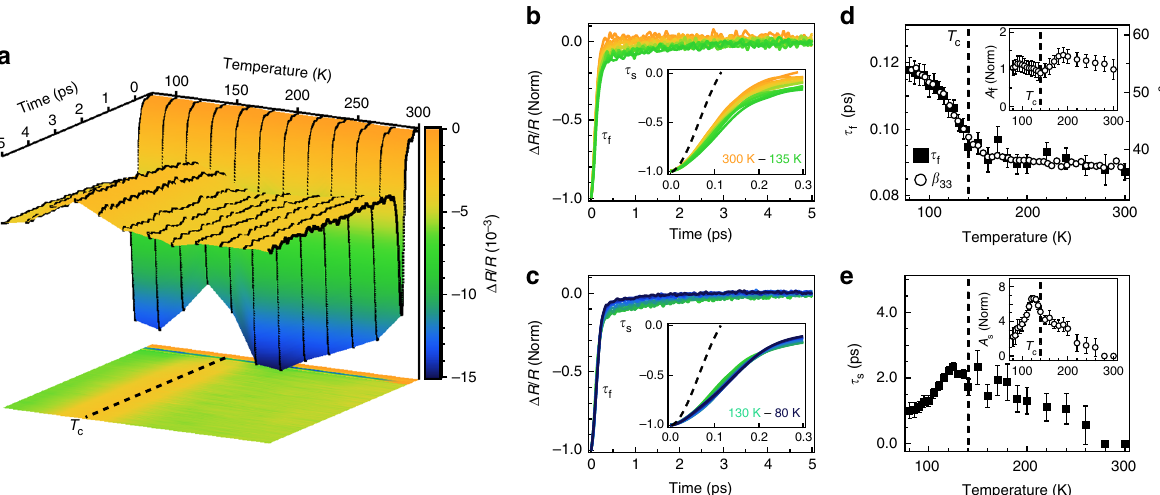
Fig. 2 Temperature dependent relaxation dynamics of LiOsO 3 . a Three-dimensional surface plot of the transient re fl ectivity Δ R / R of LiOsO 3 as a function of temperature and time delay. Black lines are raw traces at select temperatures. An image plot of this data is projected at the bottom where clear signatures of the polar transition are observed at T c ≈ 140 K. b , c Normalized re fl ectivity transients after background subtraction showing two distinct relaxation timescales, a faster relaxation with time constant τ f and a slower relaxation with time constant τ s , in b nonpolar and c polar phases. Insets: magni fi ed view of the fast decay process compared to the Gaussian instrument resolution of our experiment, shown as a black dashed line, demonstrating our experiment is not resolution limited (see Supplementary Note 3). d , e Results of modeling the re fl ectivity transients with a bi-exponential function. d Temperature dependence of τ f plotted with the anisotropic displacement parameter β 33 , a measure of the structural order parameter 8 . Inset: Temperature dependence of the fast relaxation amplitude A f normalized by its 300 K value. e Temperature dependence of τ s . Inset: temperature dependence of the slow relaxation amplitude A s normalized by its 260 K value, the temperature at which it is fi rst discernable. Error bars in d , e derive from the χ 2 of the bi-exponential fi